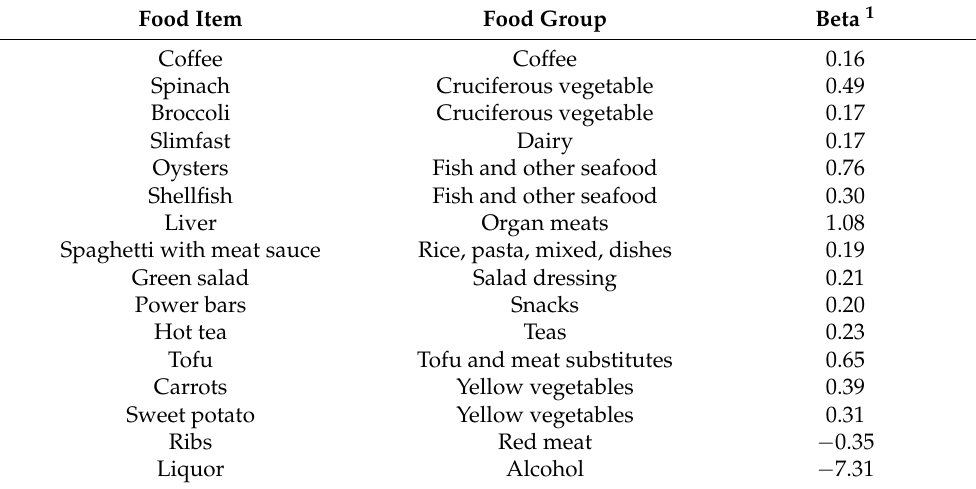
Table 2. Top food item contributors to the oxidative balance score.